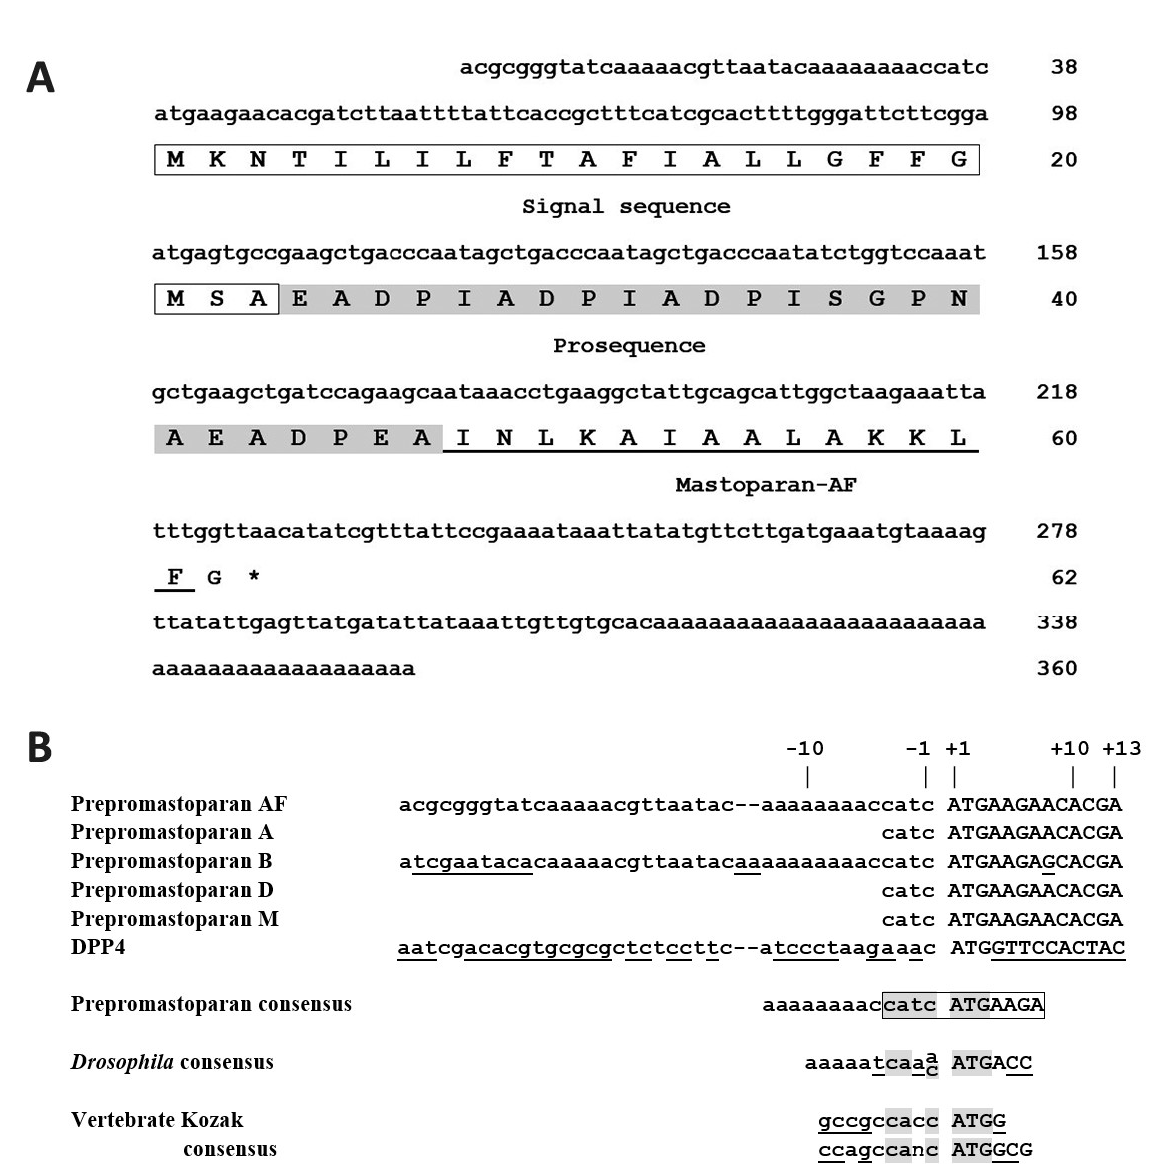
Figure 1. The cDNA sequence encoding the prepromastoparan-AF and alignment of the 5′ prepromastoparan mRNAs sequences. ( A ) The cDNA sequence (lowercase letters) encoding the prepromastoparan-AF. Number of the last nucleotide or amino acid residue in each line is labeled on the right. The amino acid sequence (1-letter abbreviations) of signal sequence, prosequence, and mature mastoparan-AF of prepromastoparan-AF is boxed, shaded, and underlined, respectively. Asterisk indicates the stop codon, TAA. ( B ) Alignment of the 5′ prepromastoparan mRNAs sequences (open reading frame in uppercase). The prepromastoparan-AF mRNA sequence flanking the translation initiation region was aligned against those of other homologs, including prepromastoparan-A from Vespa analis [6], prepromastoparan-B from Vespa basalis (DQ119291) [6,27], prepromastoparan-D from Vespa ducalis [6], and prepromastoparan-M from Vespa mandarinia [6]. DPP4 from V. basalis (DQ661743) [27] is listed in parallel. An 11-bp “CATCATGAAGA” sequence that is identical among all prepromastoparan homologs is boxed. In addition, prepromastoparan-AF and prepromastoparan-B mRNA sequences are identical from -13 to +7 (5′-AAAAAAAACCATCATGA AGA). A core consensus sequence ( − 4 to +3) that is conserved among prepromastoparan mRNAs, Drosophila consensus [30], vertebrate Kozak [31], and similar consensus [30] sequences are highlighted in gray. Nucleotides varied from prepromastoparan-AF are